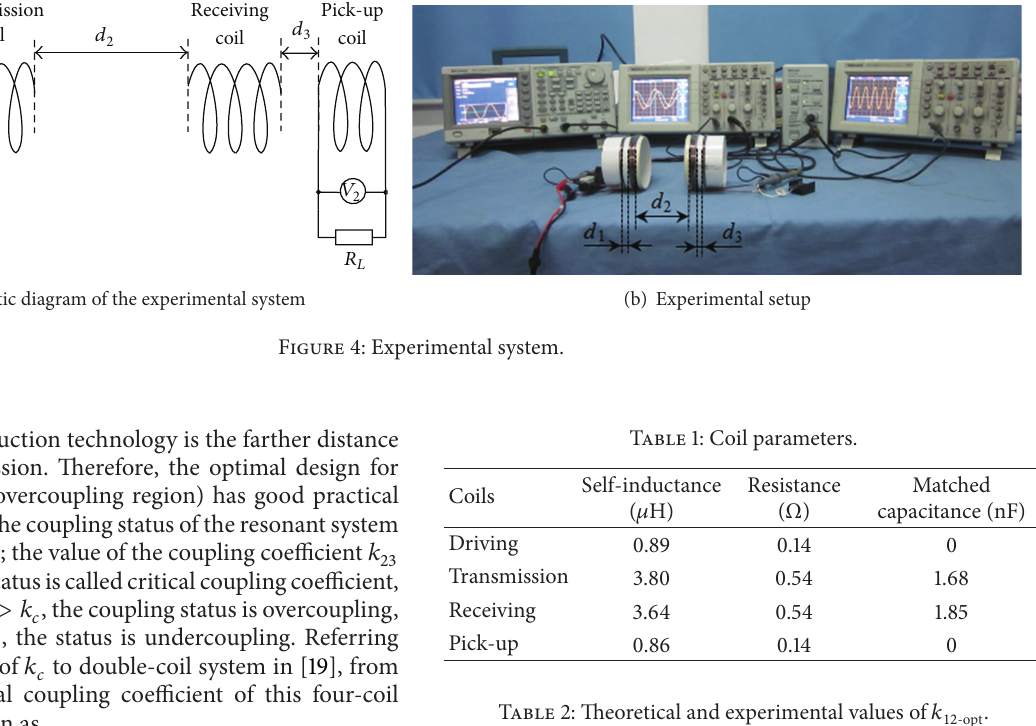
Table 2: Theoretical and experimental values of 𝑘 12